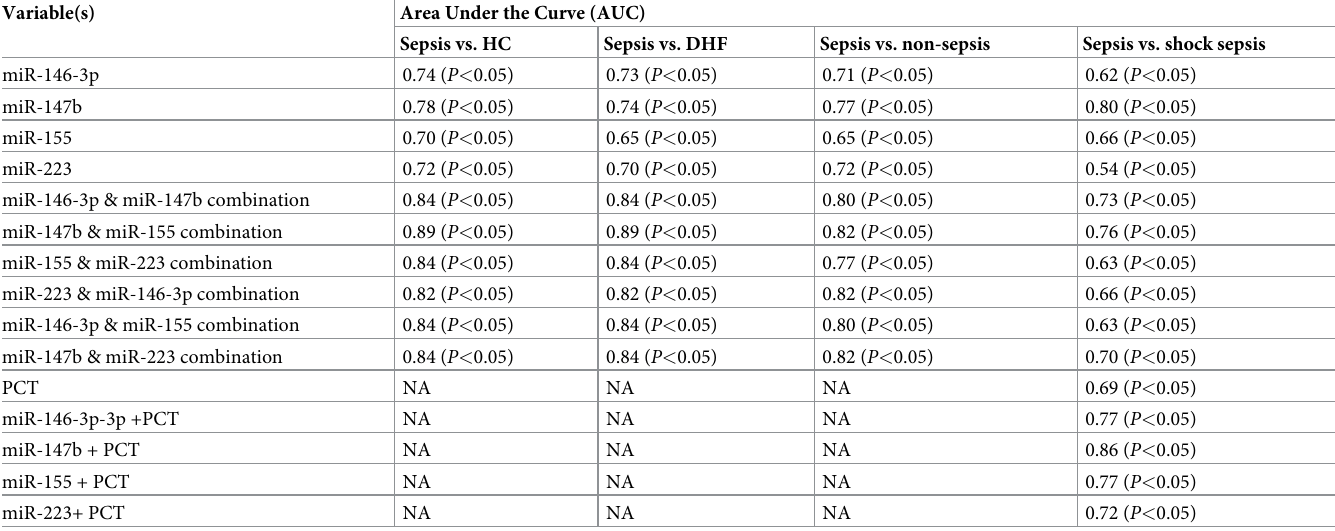
Table 3. The value of miRNA and PCT in differentiating diagnostics sepsis and non-sepsis and/or sepsis shock.